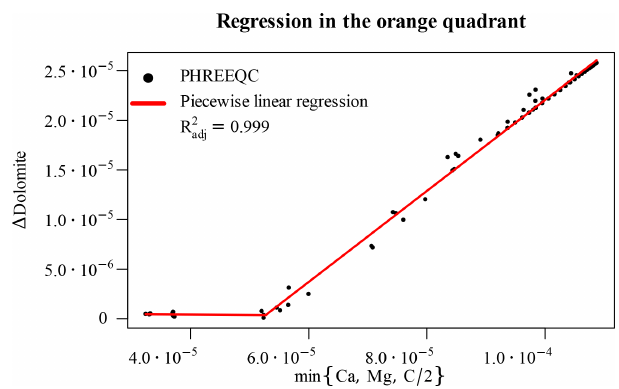
Figure 10. Piecewise linear regression for the orange-shaded top left quadrant of Fig. 6 based on the limiting elemental concentration after having considered calcite